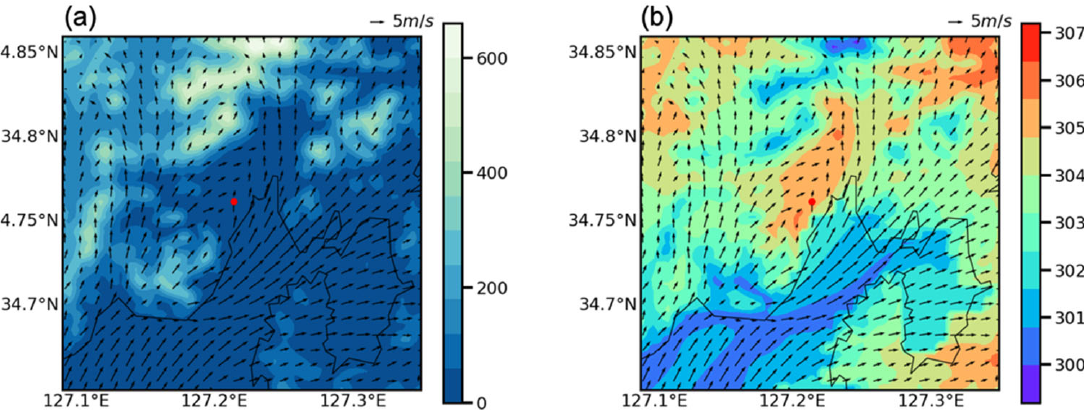
Figure 9. Horizontal distribution of simulated 10-m wind vectors with ( a ) topography and ( b ) 2-m air temperature in the analysis domain at 16:00 LST on 15 July 2018, in the default simulation (S04V). A red dot indicates the location of the BSWO.